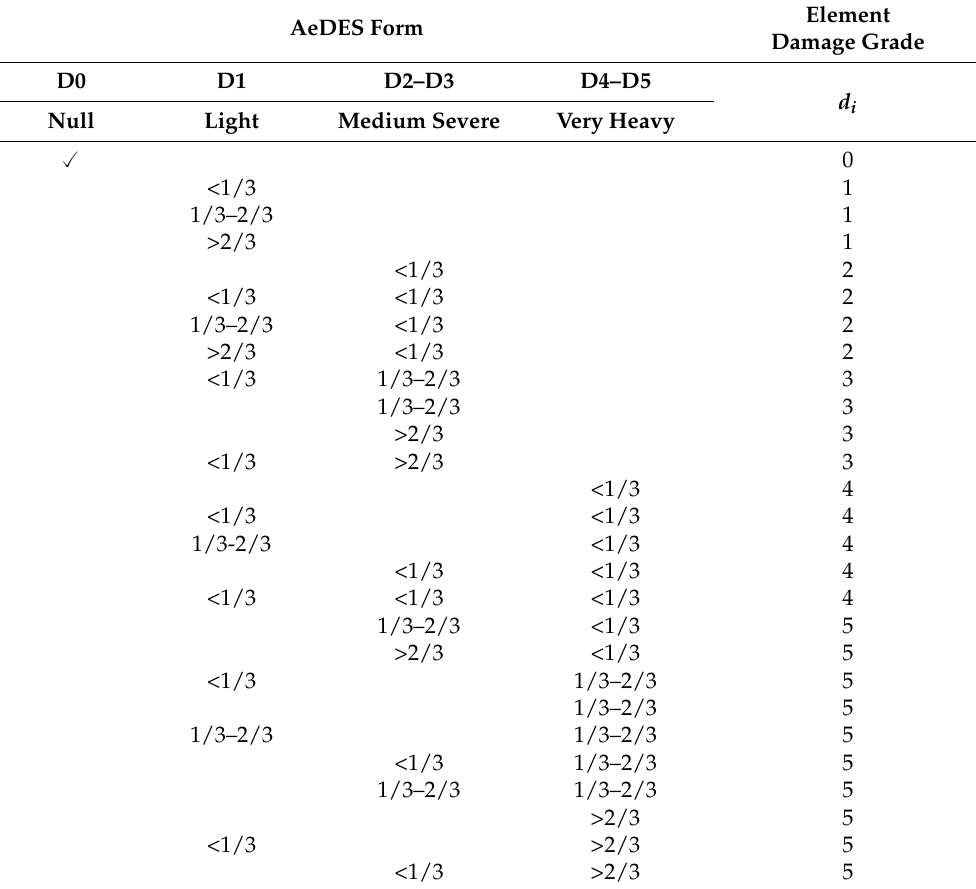
Table 3. Association of AEDES damage grades and extensions with structural element damage